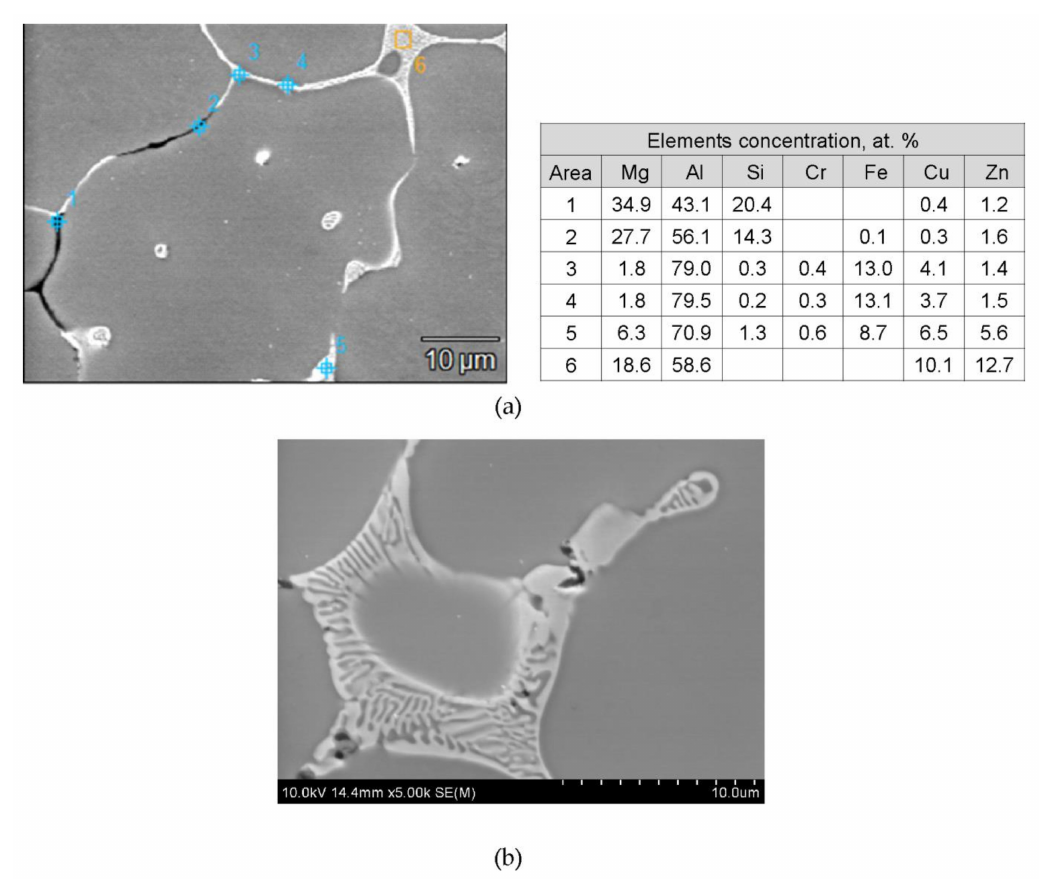
Figure 3. SEM/EDS (Scanning Electron Microscopy/Energy-Dispersive Spectroscopy) microanalyses results of eutectics and particles in the as-cast billets: ( a ) 7075 alloy 1; ( b ) 7049 alloy